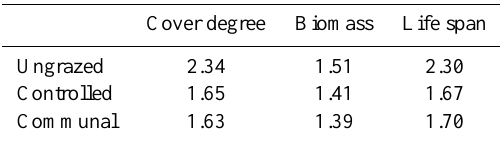
Table 3. General plant species characteristics for each grazing regime, calculated as species frequency weighted averages for the period of 2002 to